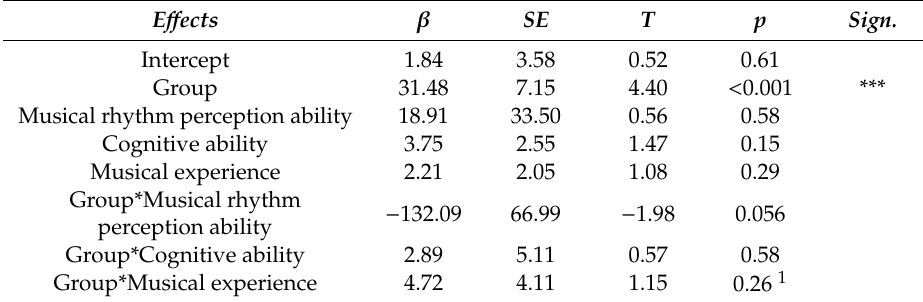
Table A10. Parameters of the regression analysis of the e ff ects of dyslexia, musical rhythm perception ability and cognitive ability on reading